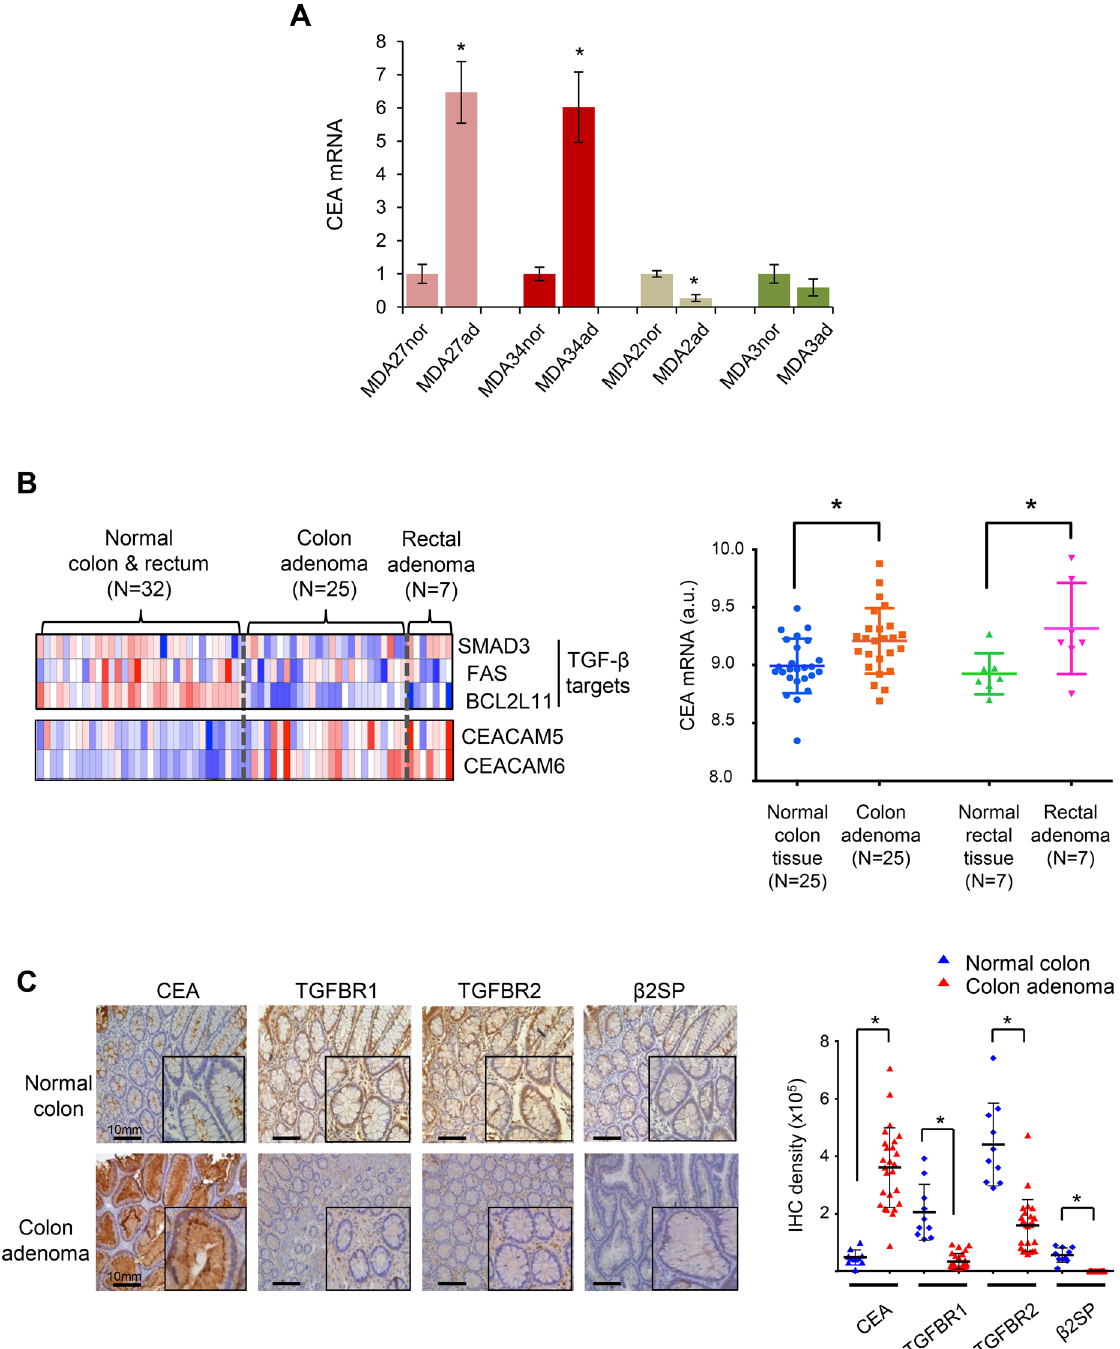
Fig 3. Enhanced expression of CEA correlates with loss of TGF- β signaling in early colon adenomas. (A) Marked increases in CEA mRNA expression levels in the highly mutated adenoma samples, MDA27ad-TA and MDA34ad-TVA. CEA mRNA expression levels were detected in 4 adenomas (MDA27ad- TA, MDA34ad-TVA, MDA2ad-TVA, and MDA3ad-SSA) and 4 matched normal mucosa samples (MDA27nor, MDA34nor, MDA2nor, and MDA3nor) by Q-RT-PCR. Results are the average of three independent experiments and are presented as mean ± SD. * p < 0.01, versus normal tissues, Student ’ s t-test. (B) Analysis of an Oncomine ™ dataset demonstrates high CEA mRNA levels in colon and rectal adenomas compared to that in corresponding normal colorectal tissue. CEA and CEACAM6 mRNA expression is inversely associated with TGF- β target gene levels in normal and adenoma colorectal tissues. Transcriptomic profiles of 32 colorectal adenoma tumors and their 32 corresponding normal colorectal tissue were downloaded from Gene Expression Omnibus database (data set GSE8671). These gene expression profiles were then analyzed using Oncomine analysis tools (www.oncomine.org). Data are displayed as a heat map using an Oncomine ™ graphic platform and as a dot plot using a GraphPad Prism v5.0 program. * : p < 0.05, Student ’ s t-test. (C)